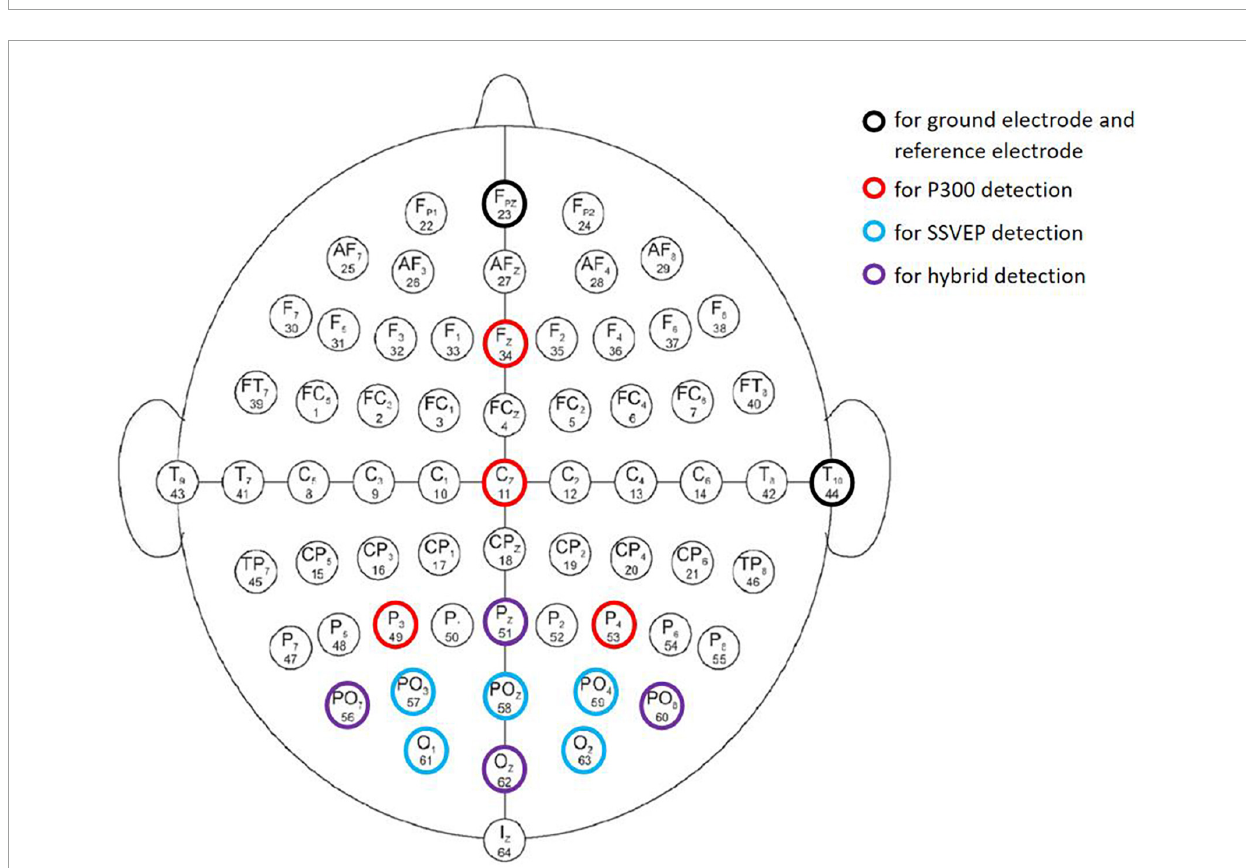
FIGURE2 Schematic diagram of arrangements of the 15 electrodes used in the experiment.